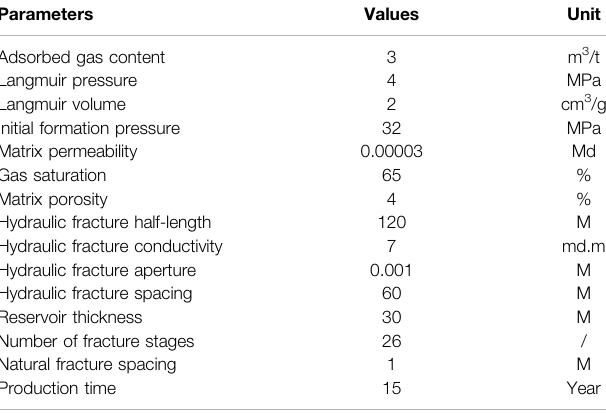
TABLE 1 | Basic parameters of shale gas numerical